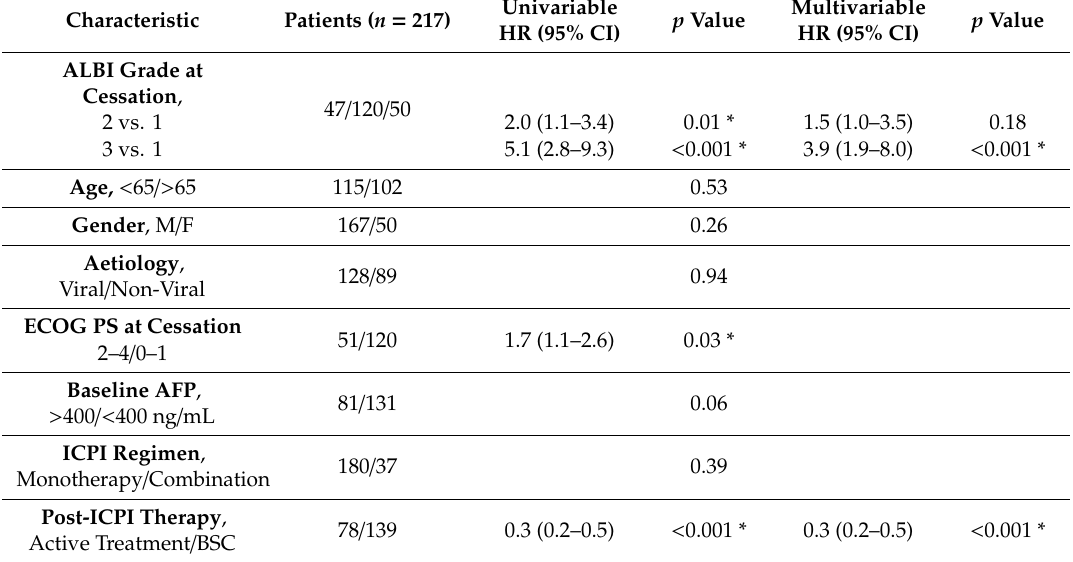
Table 5. Uni- and multi-variable analysis of PIOS in patients with HCC treated with